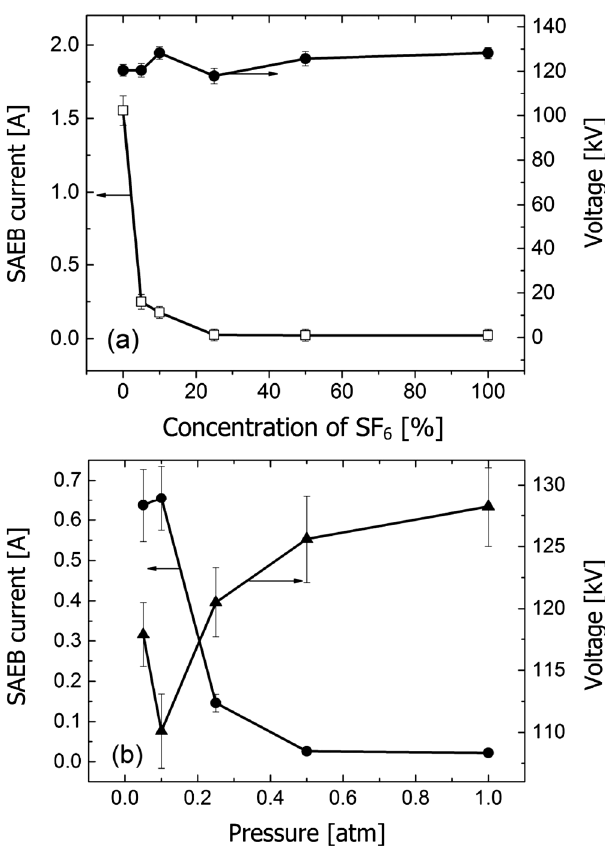
FIG. 3. Dependence of amplitude of voltage across the gap and SAEB current on the concentration of SF 6 in N 2 -SF 6 mixture (a) and on the SF 6 pressure (b). Interelectrode distance d ¼ 4